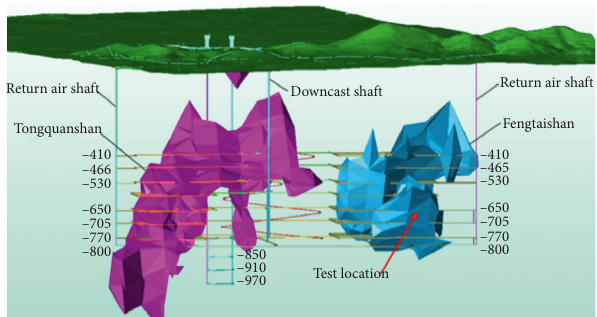
Figure 1: Tested Shaxi copper mine.